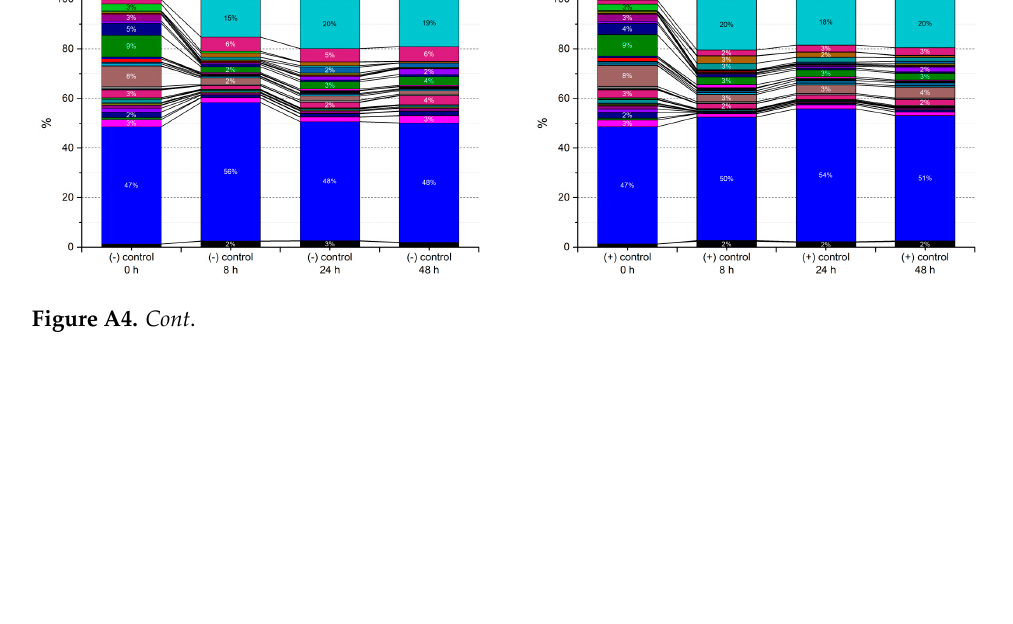
Figure A4. Bacterial DNA sequencing results of the fecal batch culture sample set treated with different hydrolyzable tannins (HTs). ( A ) Negative control, ( B ) positive control, ( C ) HT 2 = castalagin, ( D ) HT 3 = tellimagrandin II, ( E ) HT 4 = pentagalloylglucose, ( F ) HT 5 = salicarinin A, and ( G ) HT 6 = rugosin D treated samples. Labels annotated for sequences with more than 1% relative concentration. Legend titles (sequenced bacterial order, family, genus): (1) Enterobacteriales, Enterobacteriaceae , –; (2) Burkholderiales, Alcaligenaceae , Sutterella ; (3) RF32, –, –; (4) Erysipelotrichales, Erysipelotrichaceae , Catenibacterium ; (5) Erysipelotrichales, Erysipelotrichaceae , – ; (6) Clostridiales, Veillonellaceae , Veillonella ; (7) Clostridiales, Veillonellaceae , Dialister ; (8) Clostridiales, Veillonellaceae , –; (9) Clostridiales, Ruminococcaceae , Ruminococcus ; (10) Clostridiales, Ruminococcaceae , Oscillospira ; (11) Clostridiales, Ruminococcaceae , Faecalibacterium ; (12) Clostridiales, Ruminococcaceae , –; (13) Clostridiales, Lachnospiraceae , Ruminococcus ; (14) Clostridiales, Lachnospiraceae , Roseburia ; (15) Clostridiales, Lachnospiraceae , Lachnospira ; (16) Clostridiales, Lachnospiraceae , Dorea ; (17) Clostridiales, Lachnospiraceae , Coprococcus ; (18) Clostridiales,